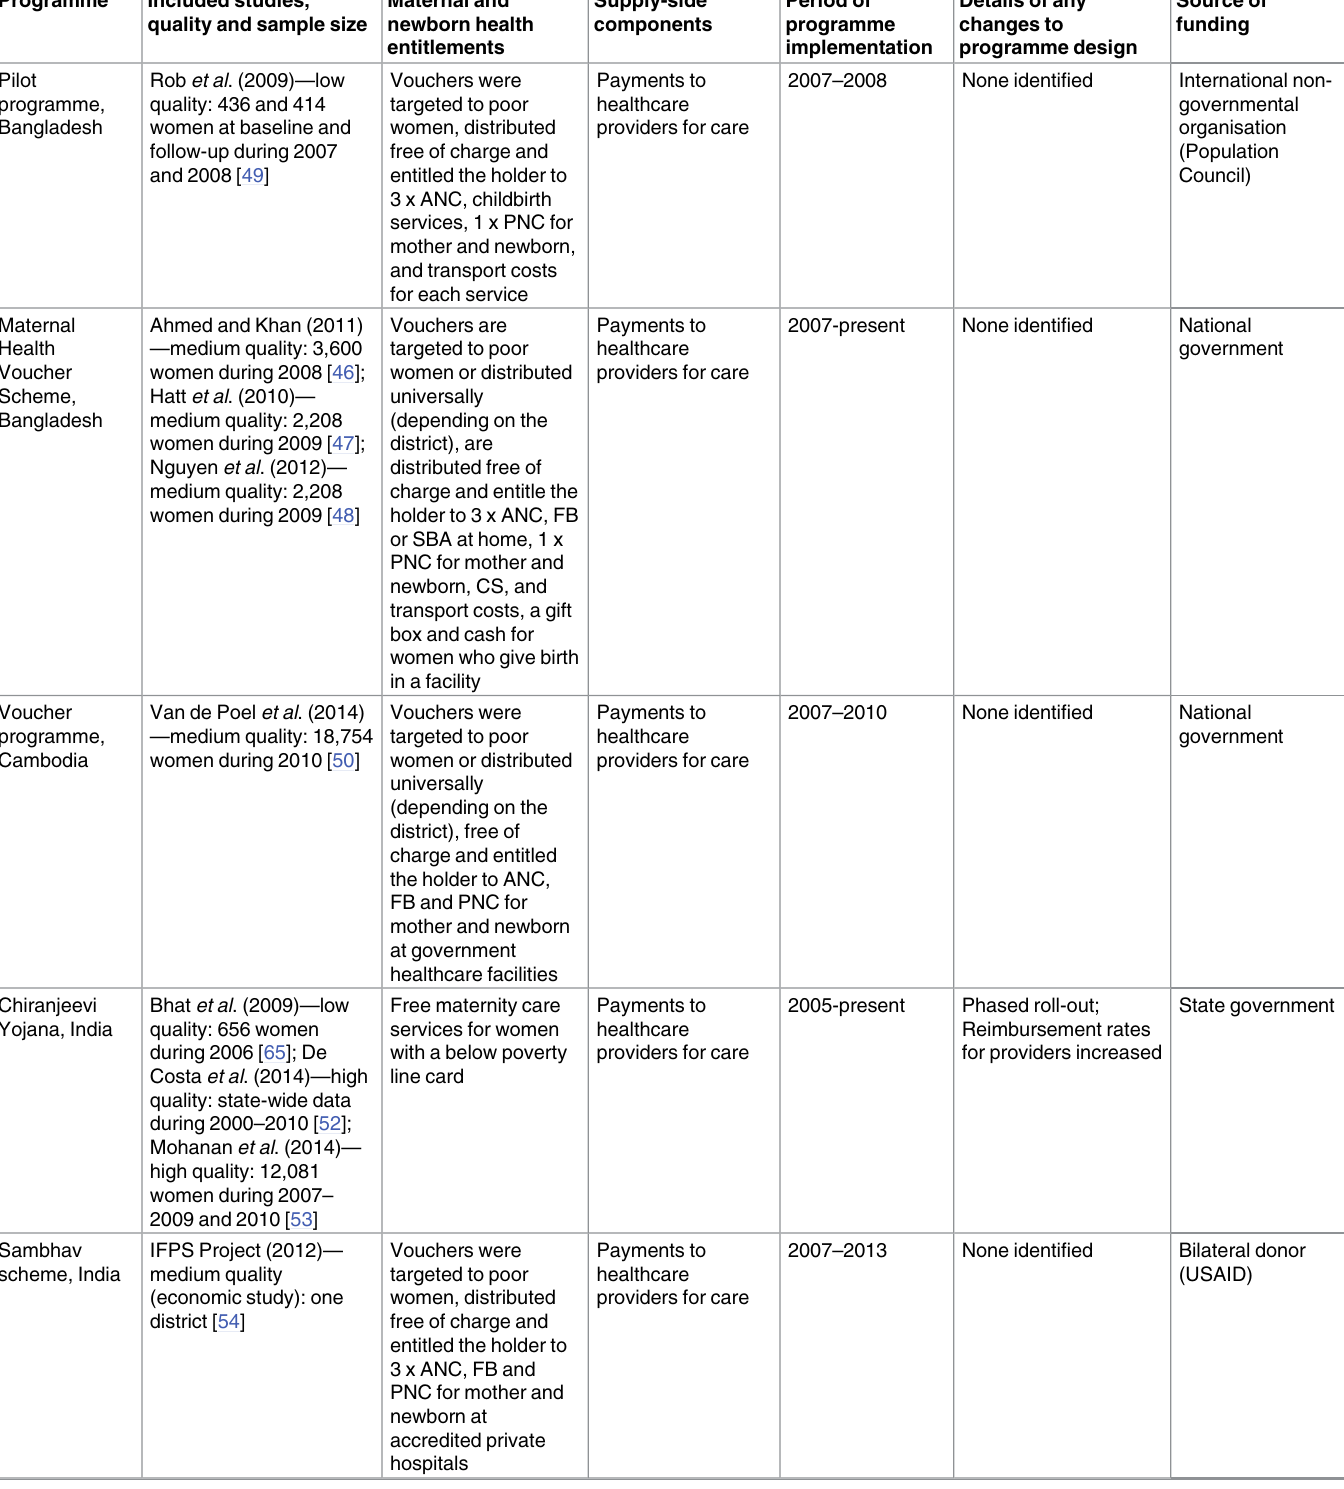
Table 6. Details of vouchers for maternity care servicesincluded in the systematicreview.